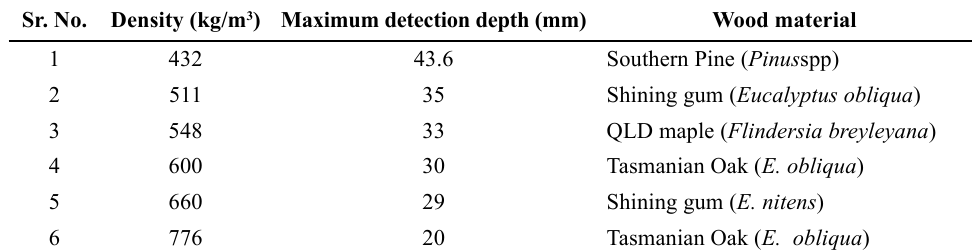
Table 3 . Maximum Termatrac™ detection depth in wood species with different